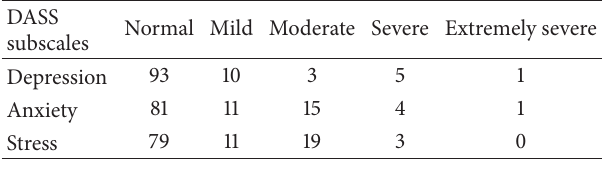
Table 2: Number of subjects scoring in various ranges on the DASS subscales.